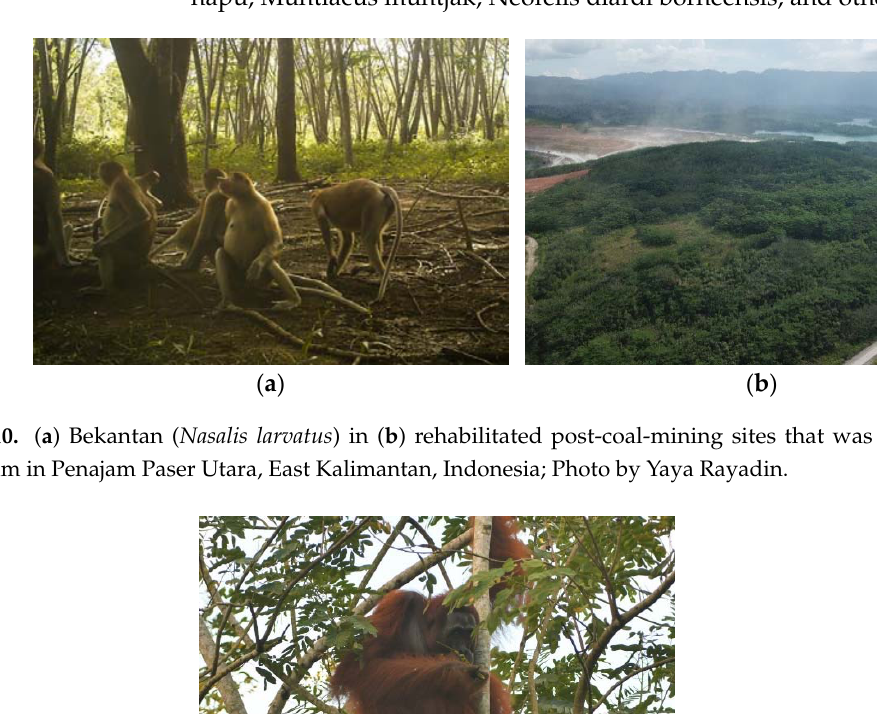
mation show that degraded ex-mining land is not impossible to make productive